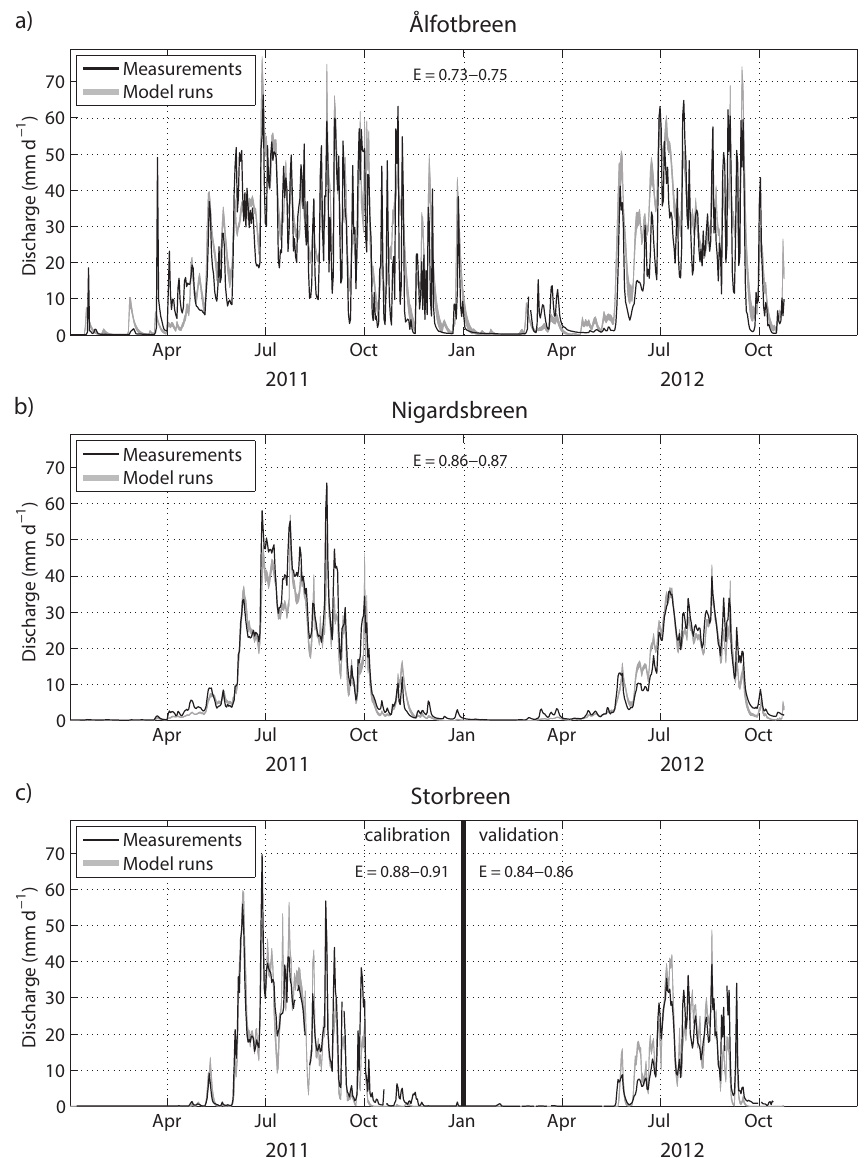
Fig. 6. Model performance for daily discharge sums at the three catchments for the validation years 2011 and 2012. Note: at Storbreen, daily discharge for 2011 is used for calibration, and 2012 for validation.